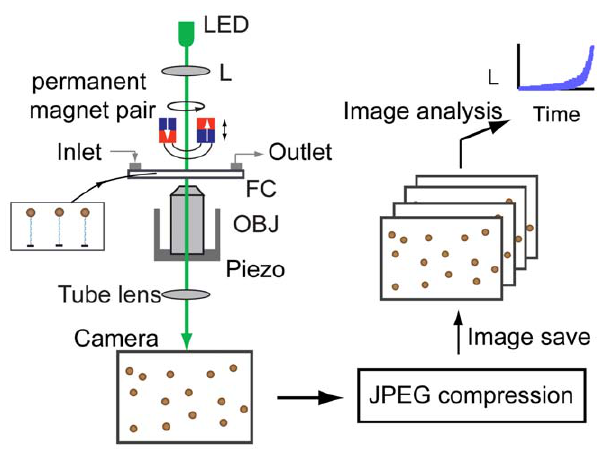
Figure 1. Principle of magnetic tweezers (MT) and increase in data throughput via parallelization. Positioning and rotation of an external magnet pair allows application of a force and torque to DNA- molecules bound to paramagnetic beads. DNA-bead tethers in the flow cell (FC) are visualized using a microscope system, consisting of an LED, a lens (L), an objective (OBJ), a tube lens and a camera. Images of the experiment are JPEG-compressed and saved to a hard drive. After the experiment, the images are analyzed and the xyz-positions of all beads in the field of view are extracted.